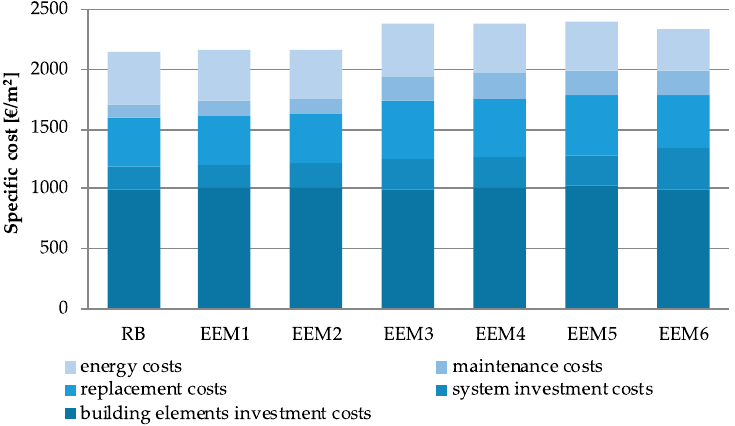
Figure 4. Example of cost calculations of different packages [17].